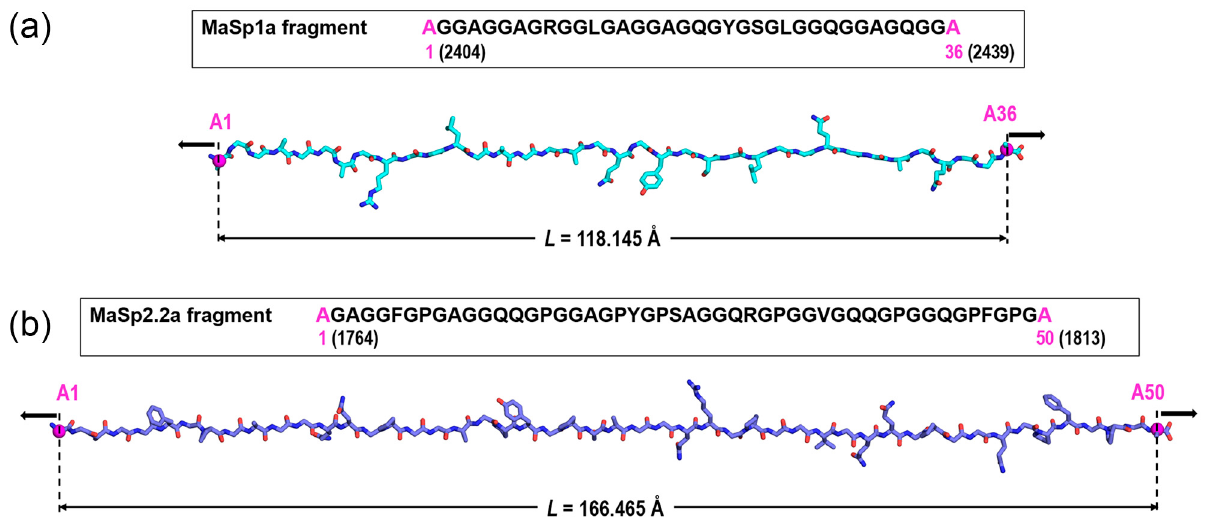
Figure 1. Sequence and extended β -pleated conformation of the selected fragments of Argiope aurantia, ( a ) MaSp1a (spidroin 1) and ( b ) MaSp2.2a (spidroin 2). Numbers in parentheses at both sequence ends indicate the corresponding residue numbers along the whole protein sequence. Distances are measured between both end C α atoms (magenta spheres) in the optimized geometries. Black arrows represent the vector forces applied at both end C α atoms.